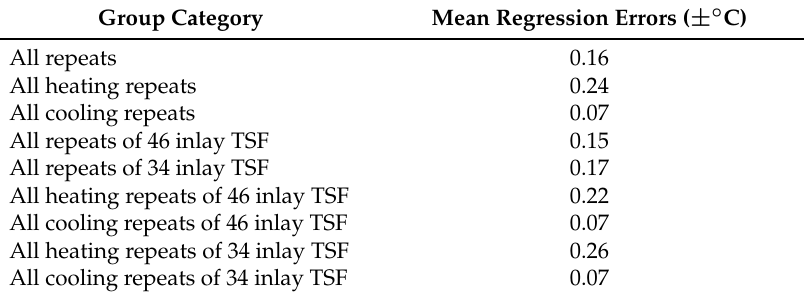
Table 3. Mean regression errors in various